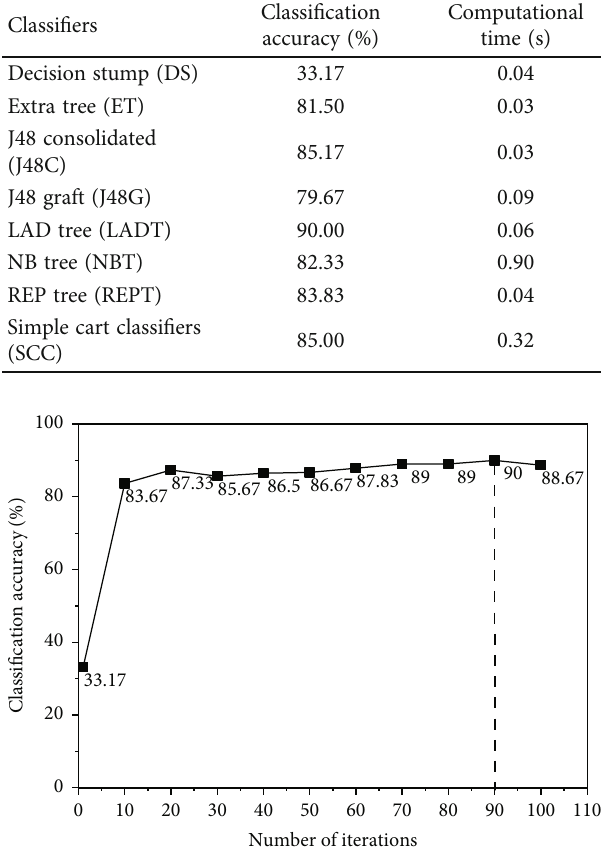
Figure 7: Number of iterations considered for LAD tree. Table 5: Confusion matrix for LAD tree.